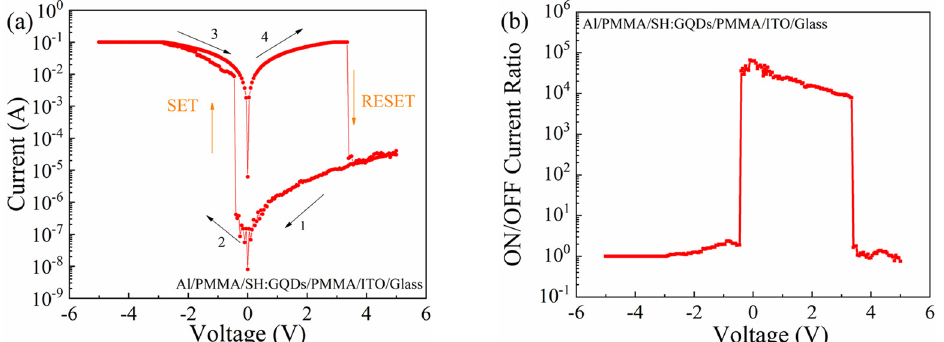
Figure 7. Al/PMMA/SH:GQD/PMMA/ITO/glass device: ( a ) I-V characteristic curve and ( b ) ON/OFF Figure 7. current ratio.